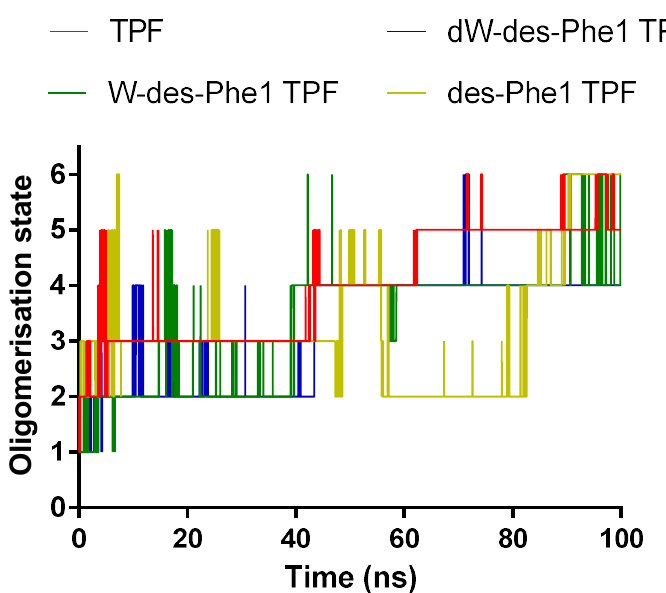
Figure 5. The changes of oligomerization state of TPF and the analogs during the 100-ns MD simulation. Each line represents the maximum oligomer size in the system.